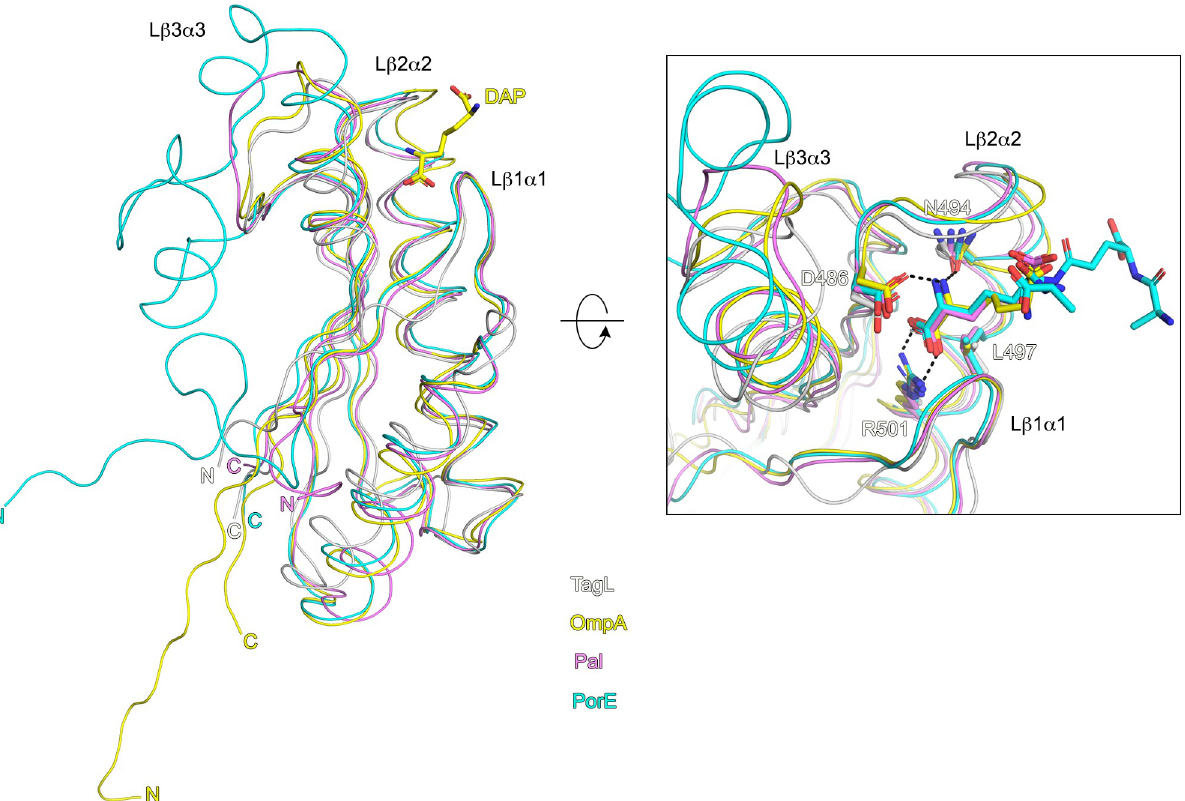
Fig 3. Superimposition of the TagL peptidoglycan binding domain (PGBD) with other OmpA family proteins in complex with a peptidoglycan (PG) fragment. Right: TagL PGDB, P . gingivalis PorE (6TOP), A . baumannii Pal (4G4V) and A . baumannii OmpA (3TD4) are displayed in white, cyan, pink and yellow, respectively. The N- and C-terminal extremities are labelled; for clarity purpose the structures are displayed as worm diagram, and only the DAP bound to A . baumannii OmpA is displayed, in stick format. Enclosed: Close-up view of the PG binding site. The PG fragments as well as the side chains of the conserved residues that interact with the DAP residue are displayed in stick format; hydrogen bonds are displayed as dashed lines. For clarity purpose, only the TagL residues are labelled. The figure was prepared using PyMOL (version 1.20,